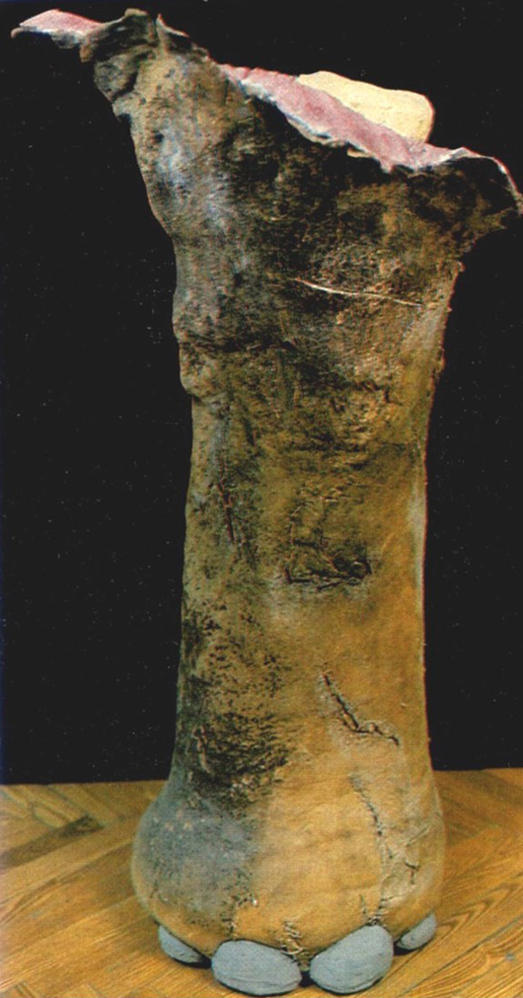
The restored right back leg of a 33,000-year-old woolly mammoth found in northeastern Siberia.